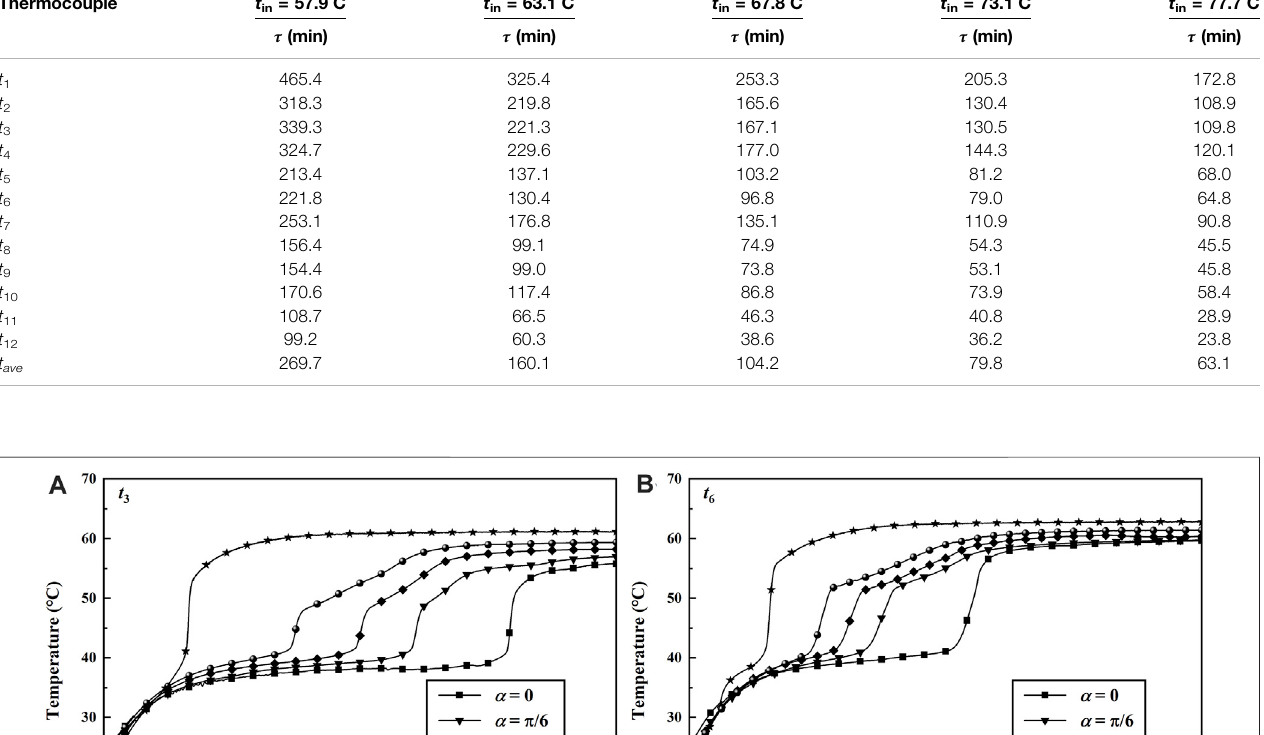
Frontiers in Energy Research |